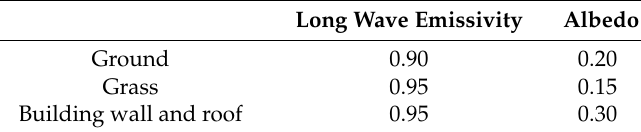
Table 7. The surface properties.